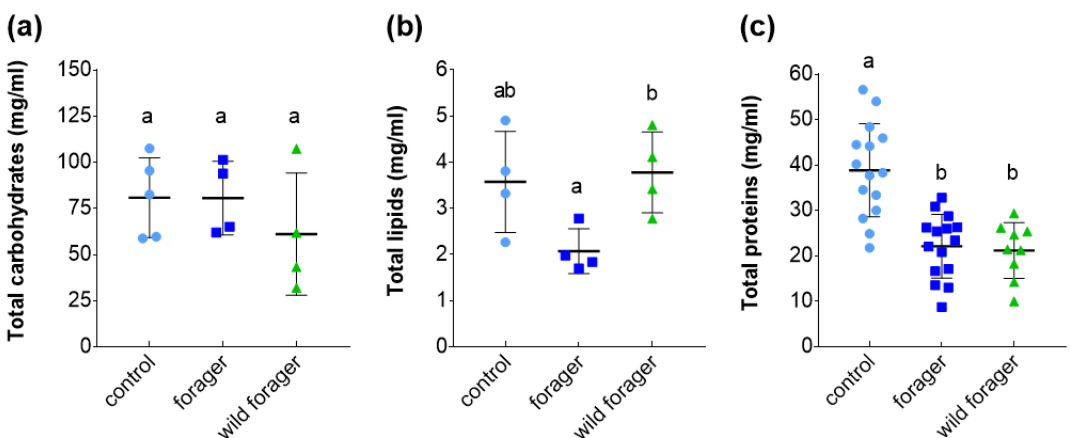
Figure 1. The total levels of nutrients in the hemolymph of non-foraging control, foraging and wild Bombus terrestris . The total concentration of ( a ) carbohydrates and ( b ) lipids were measured in the pooled hemolymph samples ( n = 4 – 5; five animals per biological replicate which means at least 20 bumble bee workers per each group); ( c ) protein concentration was determined in individual animals ( n = 9 – 15 bumble bee workers per group). Data presented as mean ± SD; significant differences p < 0.05 are indicated by different letters above the columns (Tukey ’ s test).